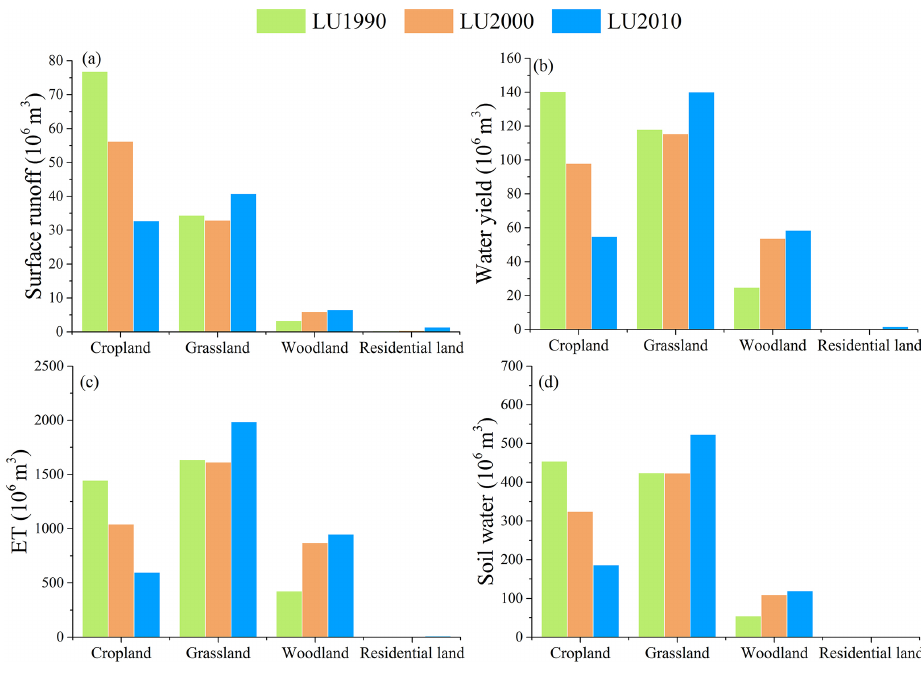
Figure 8. Calculated average annual total water volume under different land use